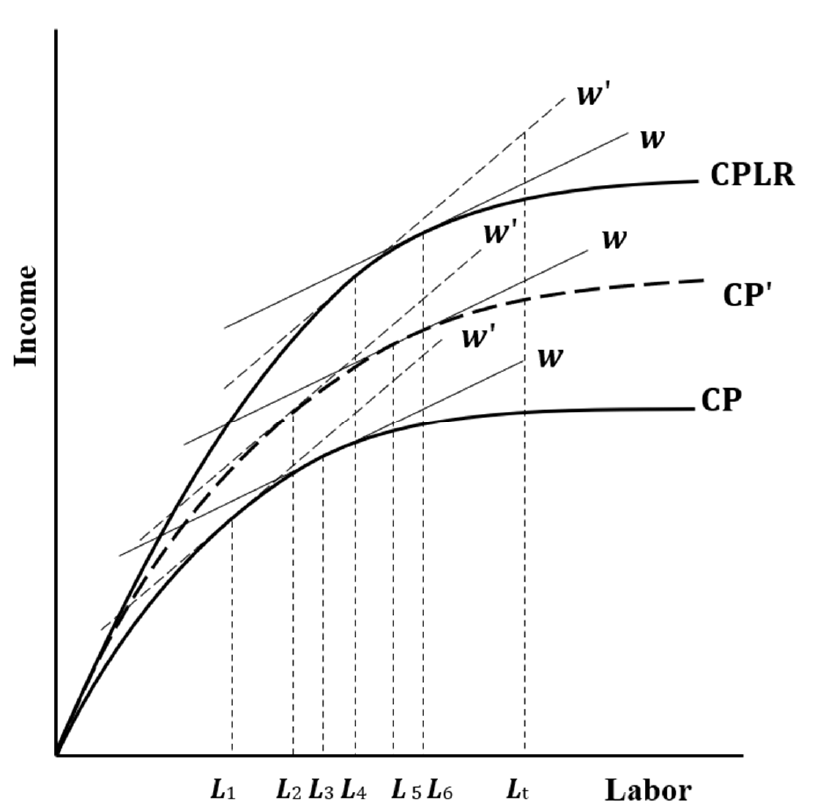
Figure 2. Mechanism of farmland abandonment in different rural households. Note: The CPLR curves represent the relationship between labor inputs and income for crop-planting and livestock- raising households; CP’ curves represent the relationship between crop-planting and livestock-raising households’ labor inputs and crop planting income. CP curve represents the relationship between crop-planting households’ labor inputs and crop planting income.